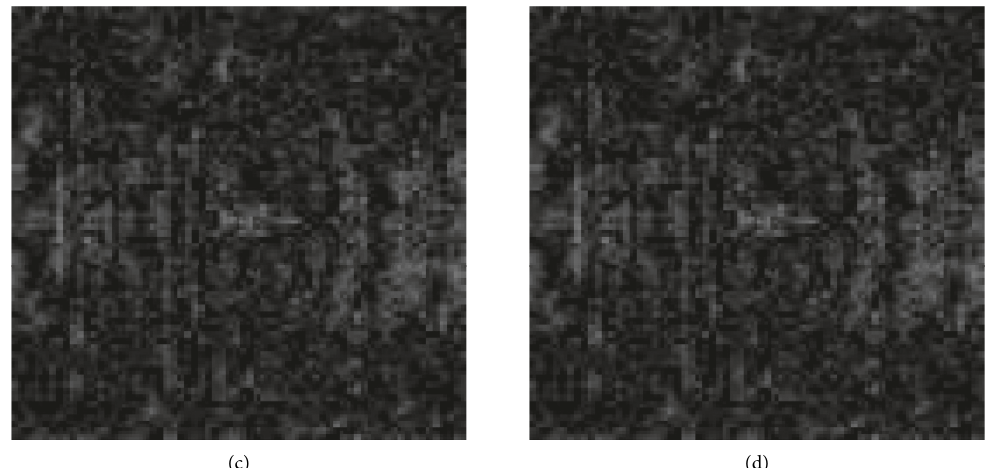
Figure 13: Decrypted results with incorrect d distances: (a) the RE plot corresponding to the deviation of distance; (b) reconstructed 2D 2 � 41mm; (c), (d) reconstructed 3D object wave with wrong distance d object with wrong distance d 2 plane, respectively.